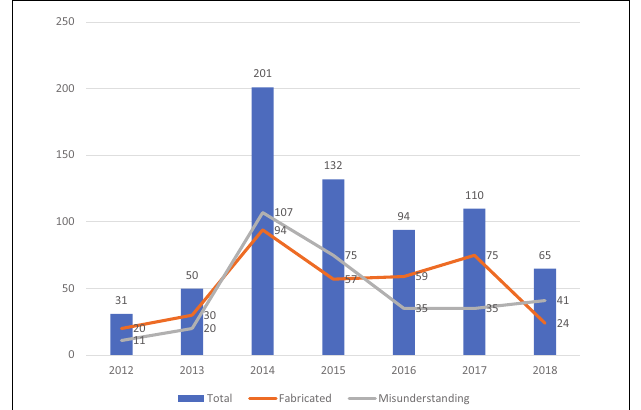
FIGURE 3 | Food rumour trends.